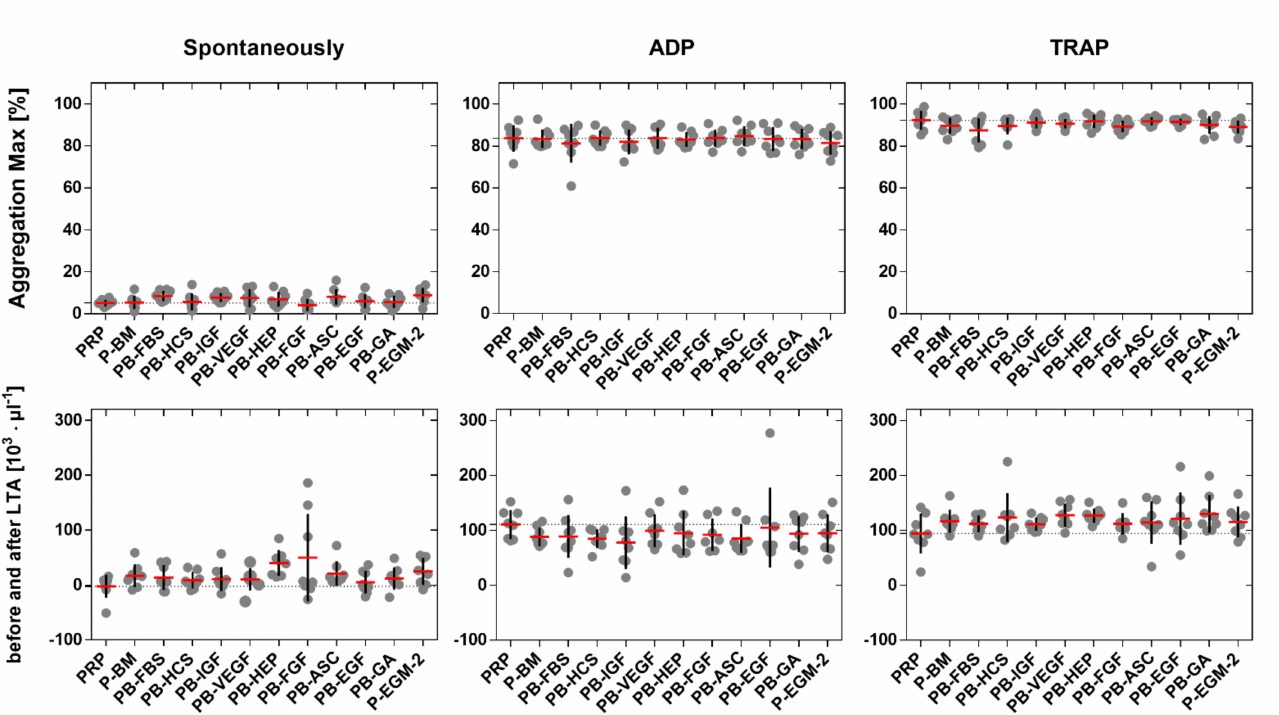
Figure 6. Aggregation of platelets. Platelet-rich plasma (PRP) was mixed with basal medium (BM) or with BM containing one of nine different supplements or with BM containing all nine supplements (see Table 1 for nomenclature) in a ratio of 1:1. PRP served as control. PLT were incubated for 10 min under rotation with different supplements (spontaneous aggregation) or in the presence of activators (adenosine diphosphate (ADP) or thrombin receptor activating peptide (TRAP)) prior to the assessment of the maximal aggregation by light transmission aggregometry (LTA) (first row). The difference of PLT number before and after LTA was calculated to indirectly assess PLT aggregation (second row). Thin dashed line shows the maximal aggregation for PRP (control). Data represent the arithmetic mean (red) ± standard deviation (black), n =